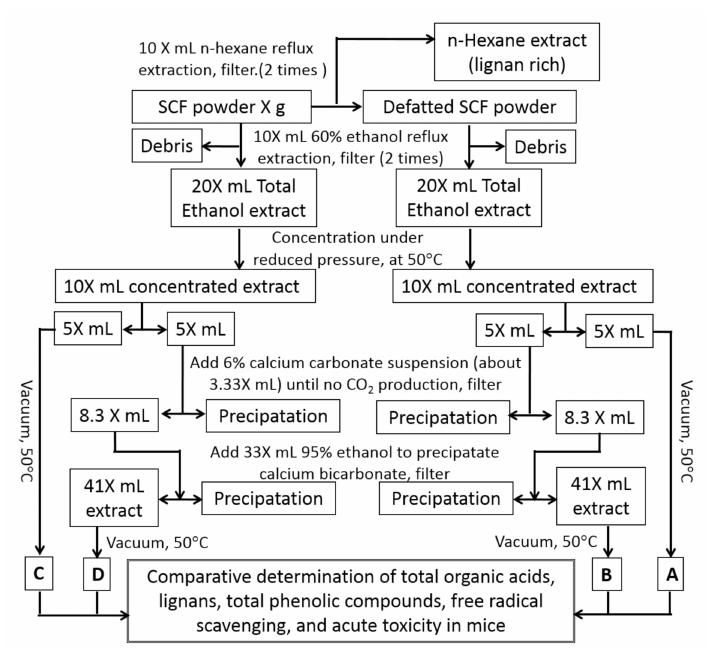
Figure 4. Scheme for the preparation of samples A, B, C, and D. Notes: Samples A and B are derived from defatted SCF powder (extracted with hexane; dashed lines); samples C and D are derived from SCF powder without hexane extraction. X represents the weight of SCF used in